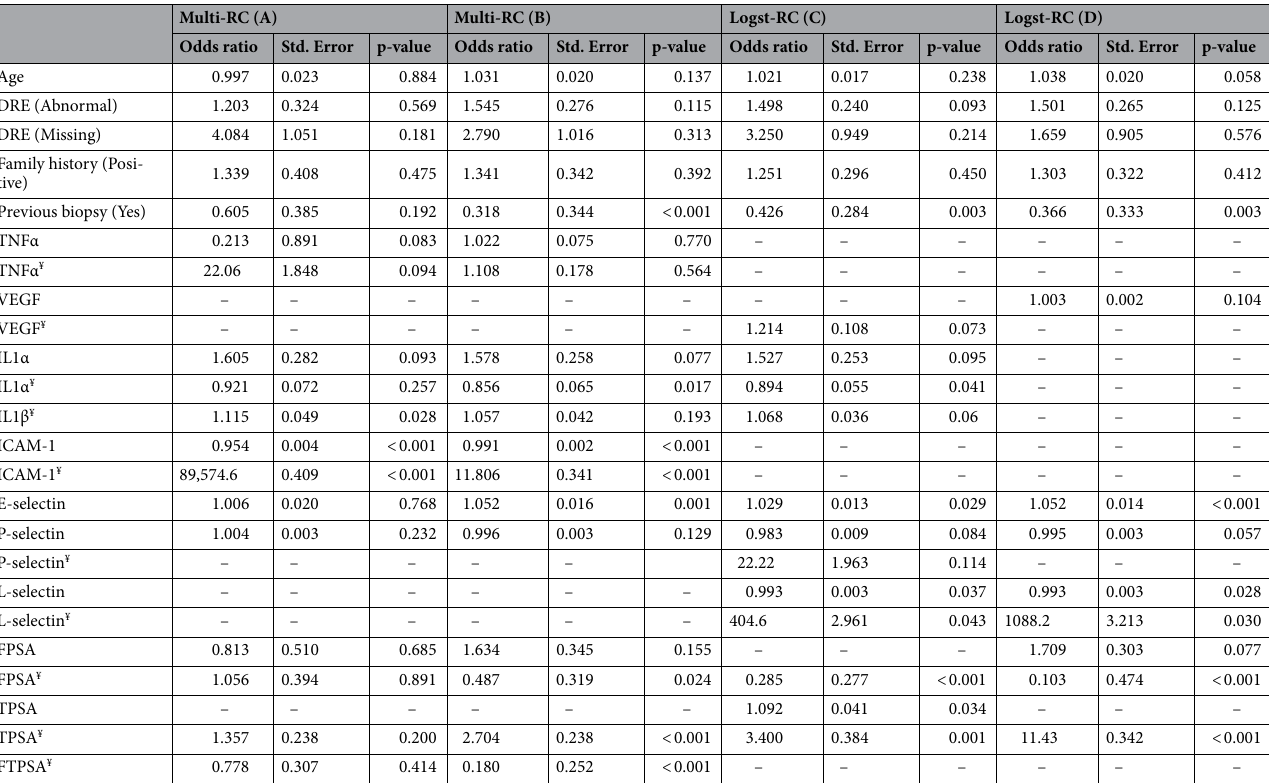
Table 3. Summary of Multi-RC and Logst-RC models using odds ratio, standard error and p-value for each risk factor in the model. ¥ The non-linear effect of the predictor using a log transformation.